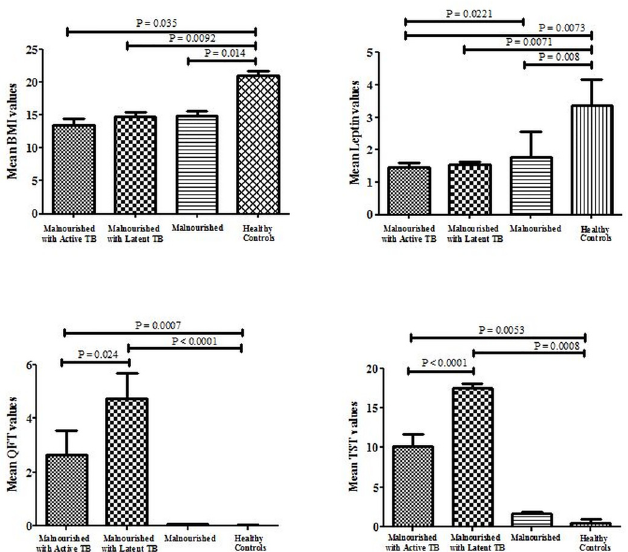
Fig 3. Mean BMI, Leptin, QFT and TST values in different categories. Bar graphs represent the mean values in different study groups. Graphs were plotted using GraphPad Prism (version 5.03). Error bars represent mean ± standard deviation. BMI- Body mass index, TST-Tuberculin Skin Test, Cut-off point is atleast 10 mm, QFT- QuantiFERON-TB Gold, Cut-off is atleast 0.35 IU/ μ l, Leptin values are indicated as absorbance at 450 nm. Leptin levels were evaluated in serum SPIbio Human EIA kit.